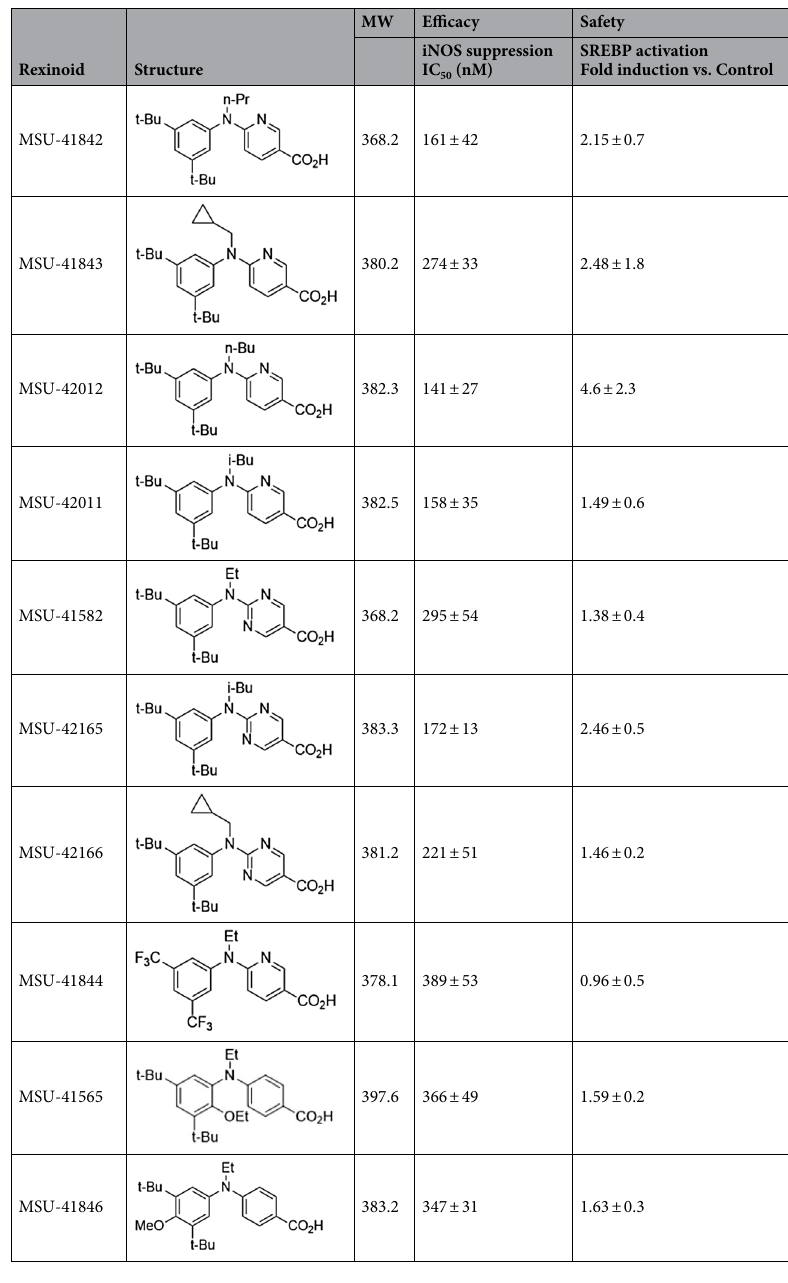
Table 1. Activity of new rexinoids in iNOS, RXR and SREBP in vitro assays. To measure iNOS suppression, RAW264.7 macrophage-like cells were treated with twofold serial dilutions (0–1000 nM) of rexinoids and stimulated with LPS (1 ng/ml) for 24 h. NO in the media was measured by the Griess assay. IC50 values were calculated, and the average IC50 values (mean ± SE) of three independent experiments are shown. To measure SREBP induction, HepG2 liver cancer cells were treated with 300 nM rexinoids for 8 h, and SREBP mRNA expression was determined by RT-PCR. Values represent mean ± SD of 3 independent